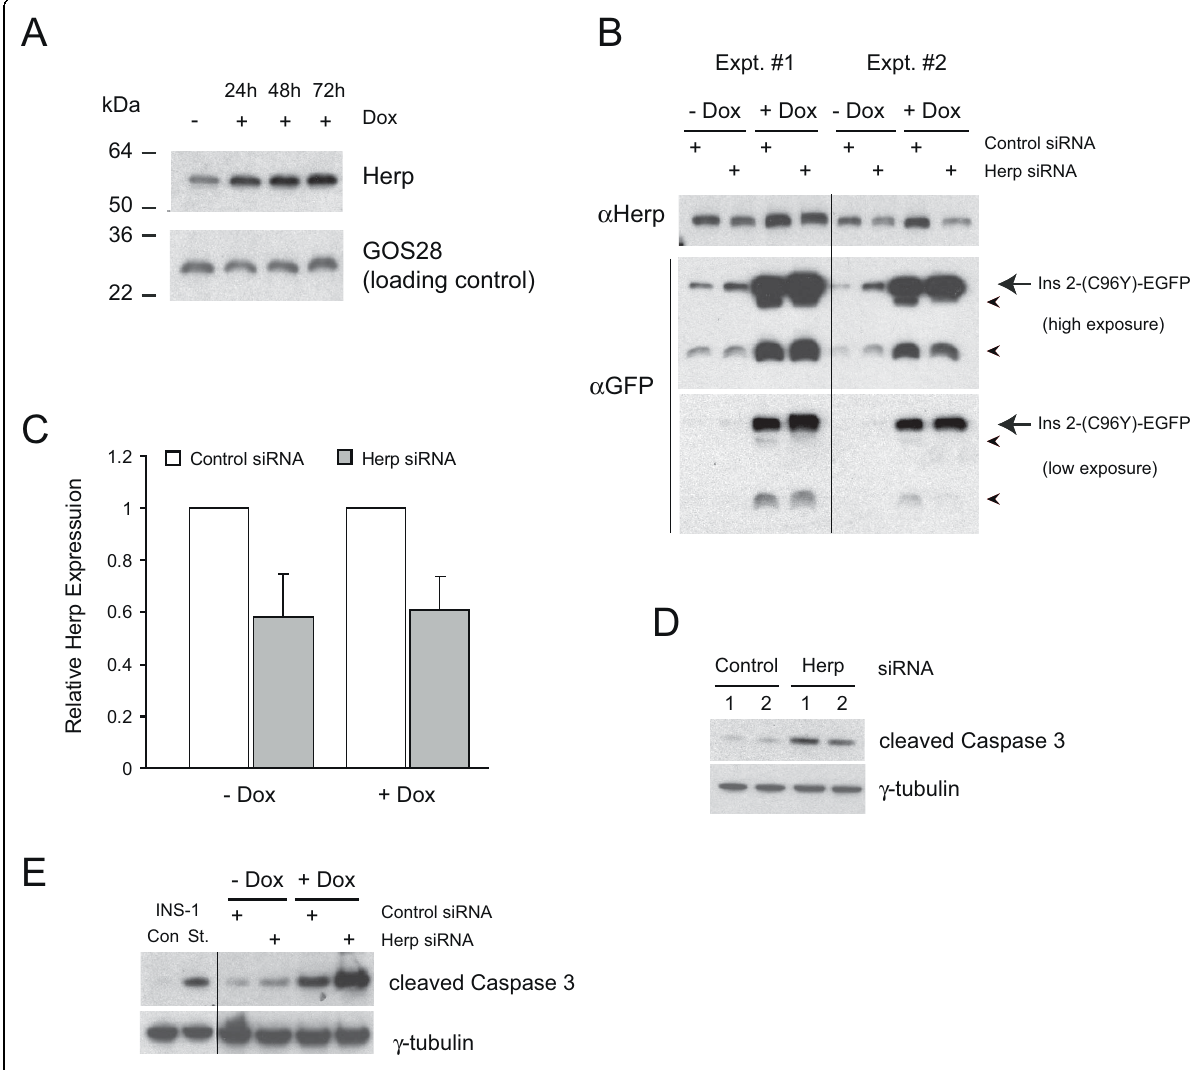
Figure 9 Inhibiting Herp expression increases insulin 2 (C96Y)-EGFP levels and enhances apoptosis . A . Clone #4S2 cells were untreated or treated with 2 μ g/ml doxycycline for the times indicated and cell lysates were prepared and immunoblotted. B . Clone #4S2 cells were transfected with control siRNA or an siRNA directed against Herp and treated or not with doxycycline for 48 h. Cells were lysed and immunoblotted as indicated. A low and high exposure of the anti-GFP western blot is shown. Results from two of four independent experiments are shown. C . Immunoblots were quantified and the mean relative expression of Herp from 4 independent experiments is presented. D . Clone #4S2 cells were transfected with control or Herp siRNA and 48 h later apoptosis was measured by immunobloting for cleaved caspase 3. Results from two experiments are shown. E . Clone #4S2 cells were transfected as in (D) and 24 h later doxycycline was added or not for 48 h and apoptosis was measured by immunobloting for cleaved caspase 3. INS-1 cells treated or not with 0.3 mM straurosporine (St.) was included as a positive control for cleaved caspase